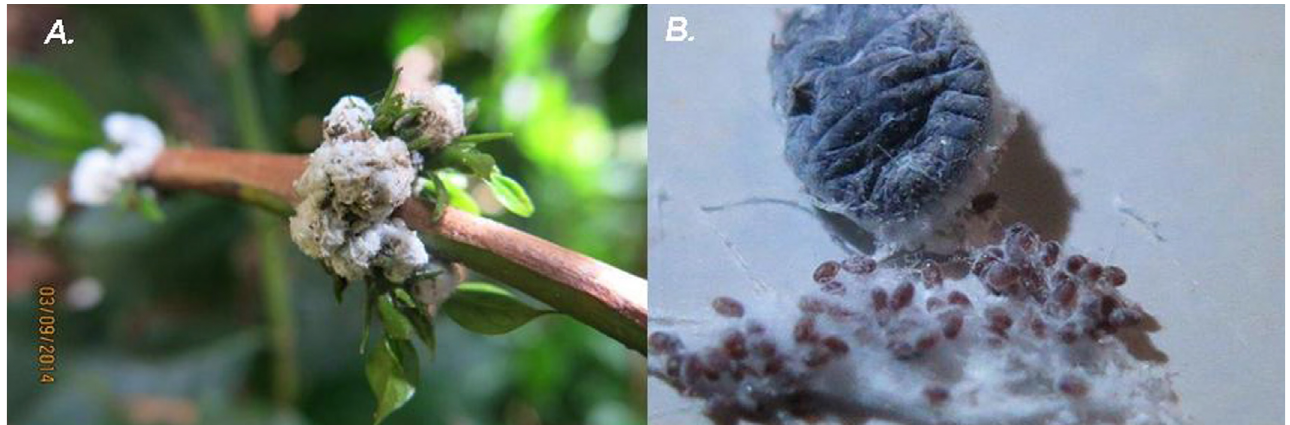
Figure 1. Nipaecoccus coffeae : cottony sac (A); ovipositing adult female containing eggs in the cottony sac